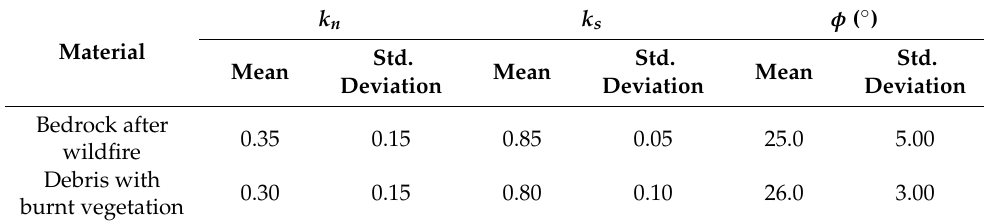
Table 1. Selected inputs for rockfall analysis with RocFall in Chandebrito [116]. k n k s φ ( ◦ ) Material Std. Std. Std. Mean Mean Mean Deviation Deviation